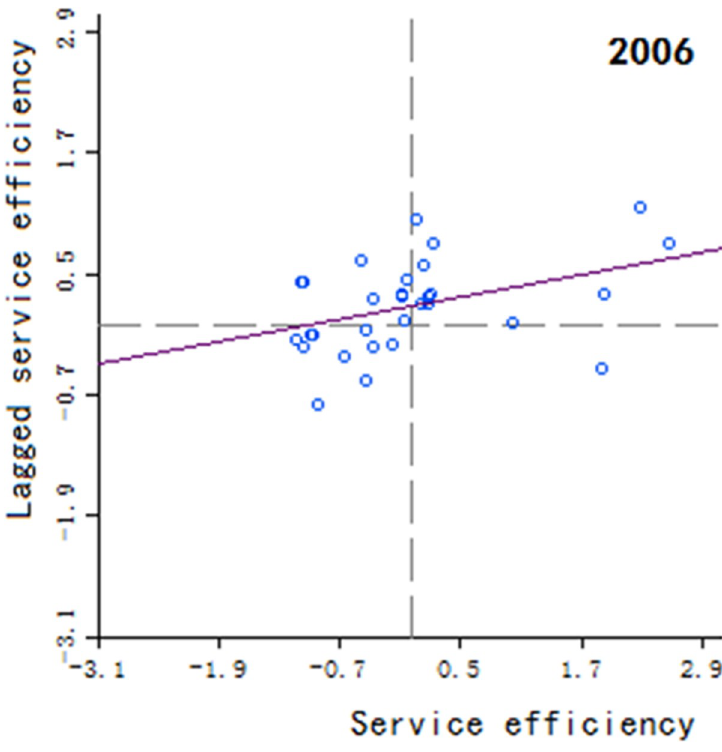
Fig 3. Scatter plot of China’s regional medical and health service level distribution from 2004 to 2018.